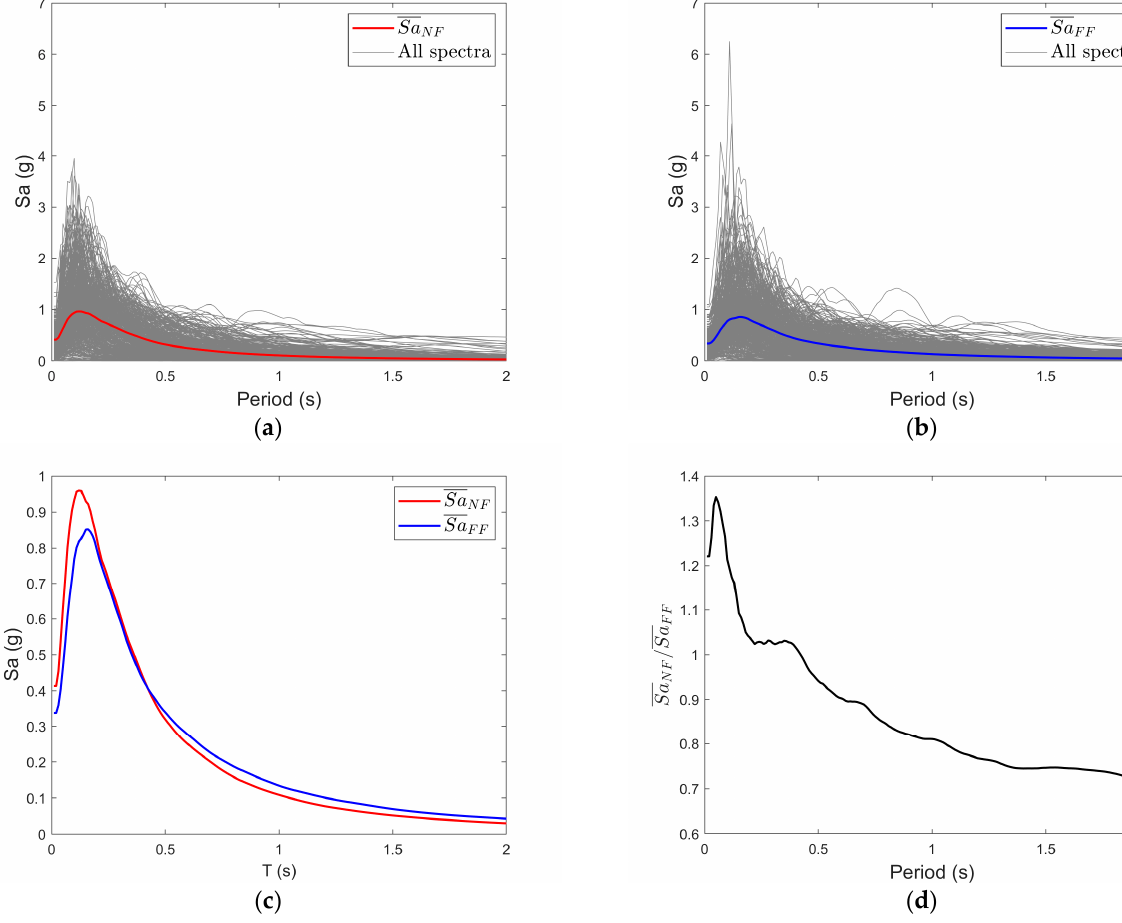
Figure 3. ( a ) Response spectra of the near-fault records; ( b ) response spectra of the far-fault records; ( c ) comparison between the mean spectrum of each subset; ( d ) ratio between the mean spectrum for near and far-fault records.